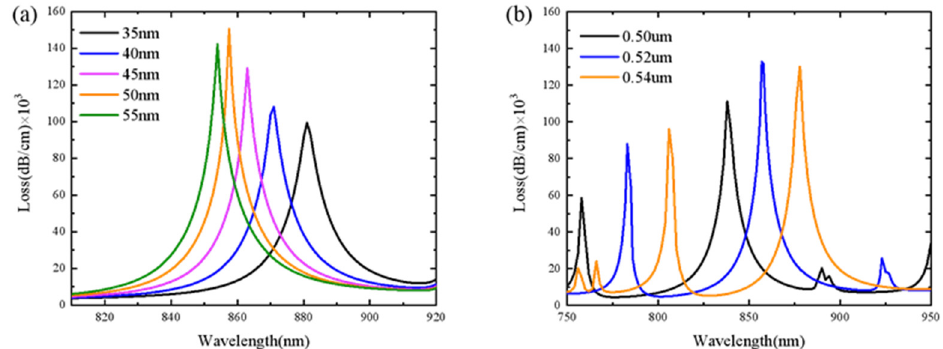
Figure 3. The loss spectrum with ( a ) different thicknesses of gold film and ( b ) different radii of the filled holes.